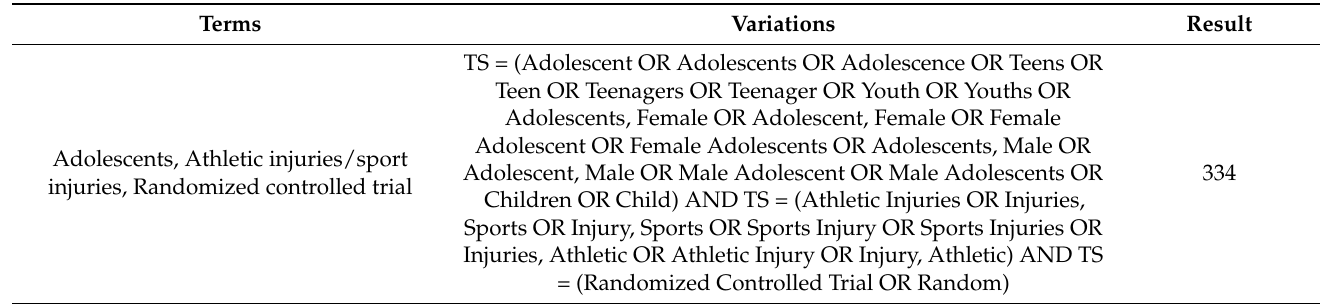
Table A4. Web of Science (Core Collection) Search Terms and Variations Used for Systematic